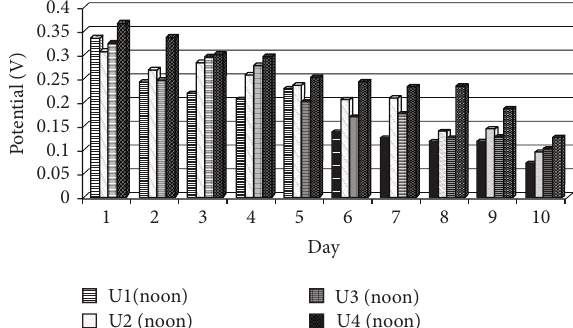
Figure 14: Graph of the average values of potential (V) at noon (12– 1pm) upon sunlight illumination for ten days where respective cell; metal oxide; U1 and U2 (without and with additive, resp.), treated metal oxide with ultrasonic; U3 and U4 (without and with additive, resp.).